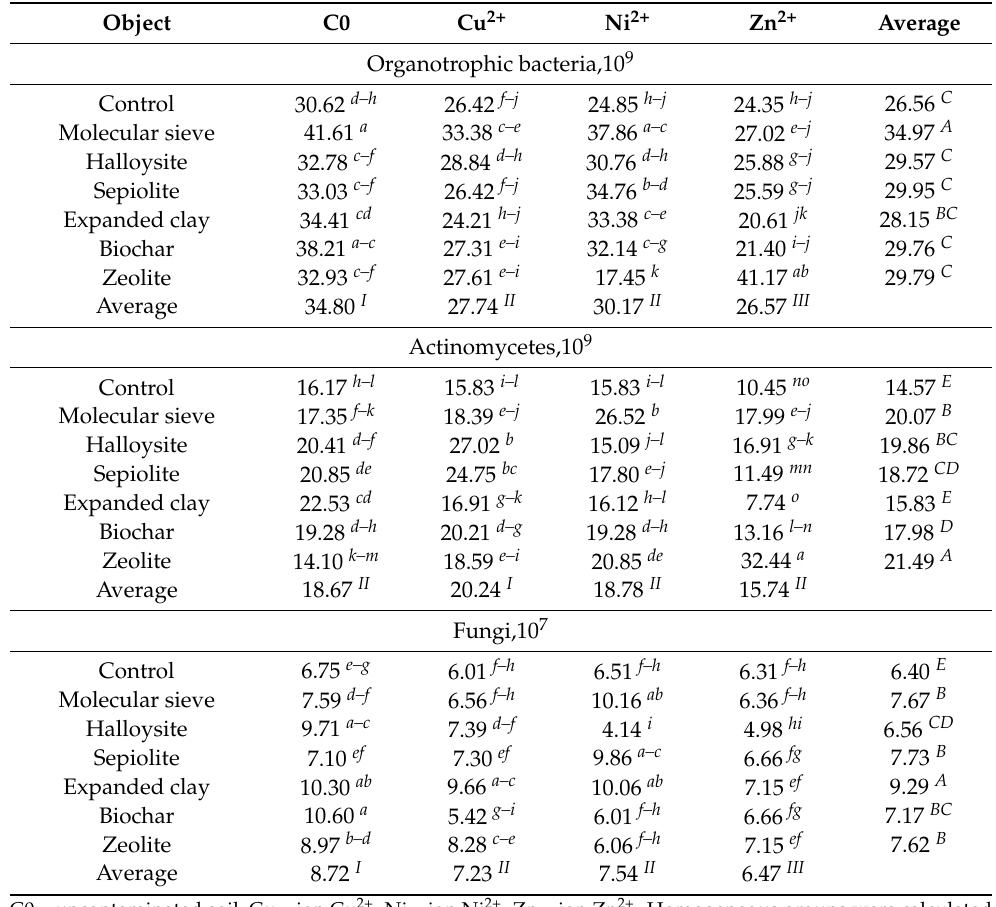
Table 2. The number of bacteria, cfu · kg − 1 d.m. of